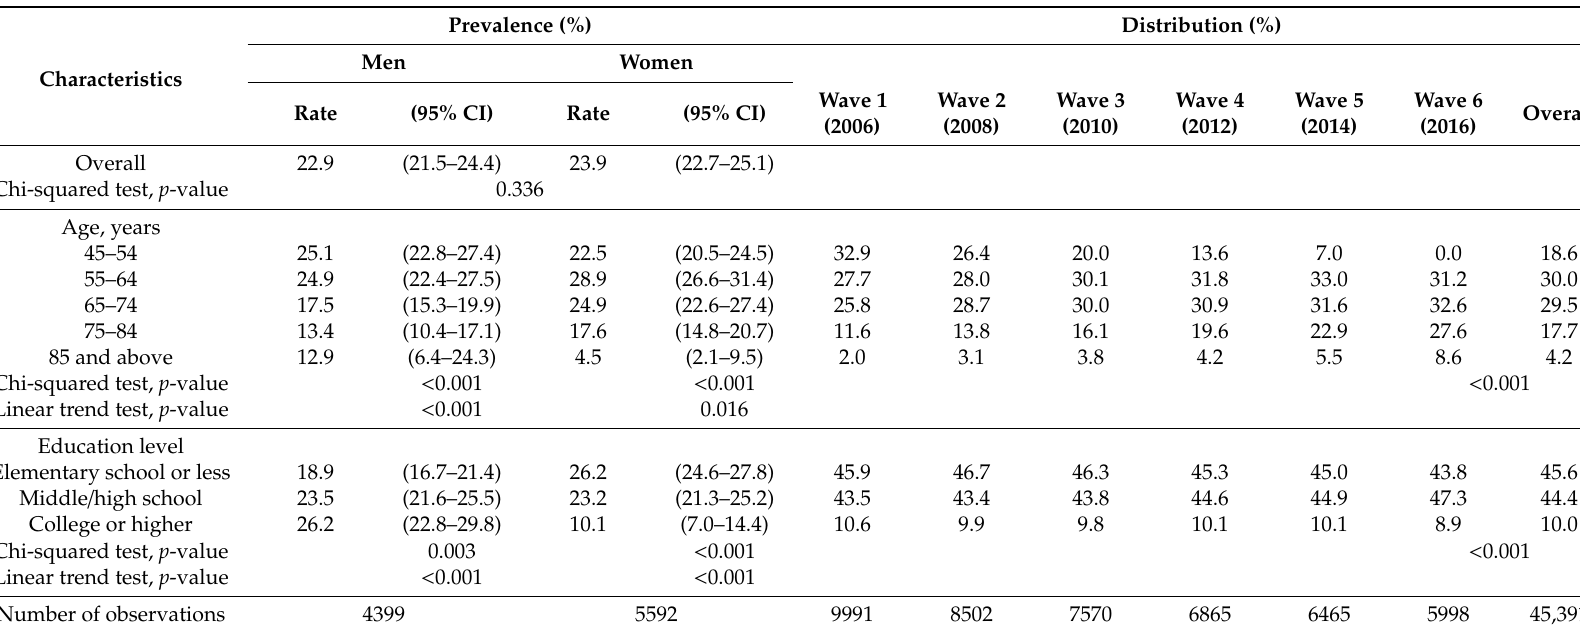
Table 2. Prevalence of obesity across all age groups and education levels by gender at baseline (Wave 1), and the distribution of observations across all age groups and education levels by each